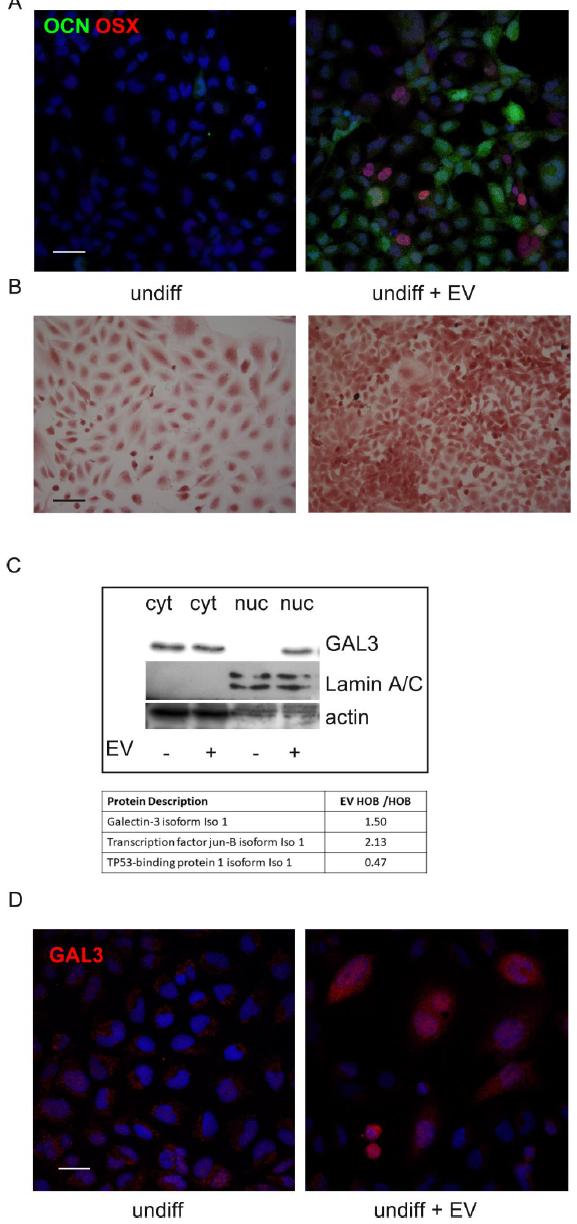
Figure 5. Effect of AFSC-EV supplementation on osteogenic differentiation process of undifferenti- ated HOB. ( A )—Representative images showing DAPI (blue) and OCN (green) and osterix (OSX) (red) signals of undifferentiated HOB cells incubated or not with EV. Scale bar= 30 µ m. ( B )—Representative images of Alizarin Red staining of HOB cells incubated or not with AFSC-EV are shown. Scale bar= 50 µ m. ( C )—Table shows mass spectrometry semi-quantitative analysis of nuclear proteins identified in undifferentiated HOB treated or not with EV. The ratio between EV-treated HOB and untreated is shown for the proteins identified in both the samples and involved in osteogenic differentiation process. WB analysis of nuclear (nuc) and cytosolic (cyt) lysates of undifferentiated HOB cells treated or not with AFSC-EV, then revealed with anti-Galectin3, anti-lamin A/C, as nuclear marker, and anti-actin, as a loading control. ( D )—Representative images showing DAPI (blue) and Galectin-3 (red) signals of undifferentiated HOB cells incubated or not with EV. Scale bar = 10 µ